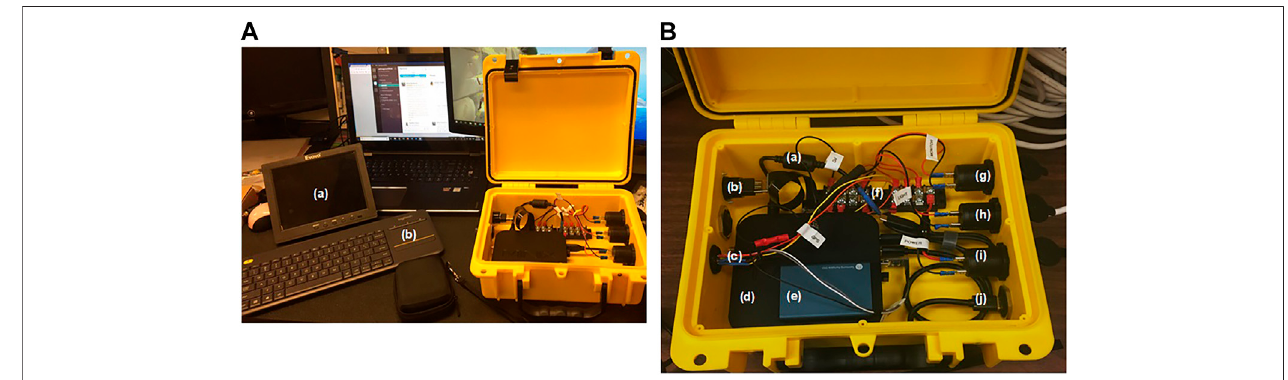
FIGURE2| YieldMonitor. (A) showsthemaincomponents oftheyieldmonitoringsystemincludingthemonitor (A) and keyboard (B) . (B) depictsthecomponents withinthecontrolboxincludingthecomputerpowerline (a) ,HDMIinput (b) ,GPSsensorattachment (c) ,MINIXcomputer (d) ,externalsolid-statedrive (e) ,terminalblock (f) , 12-V power sockets (g – i) , and USB input for the webcam (j) .